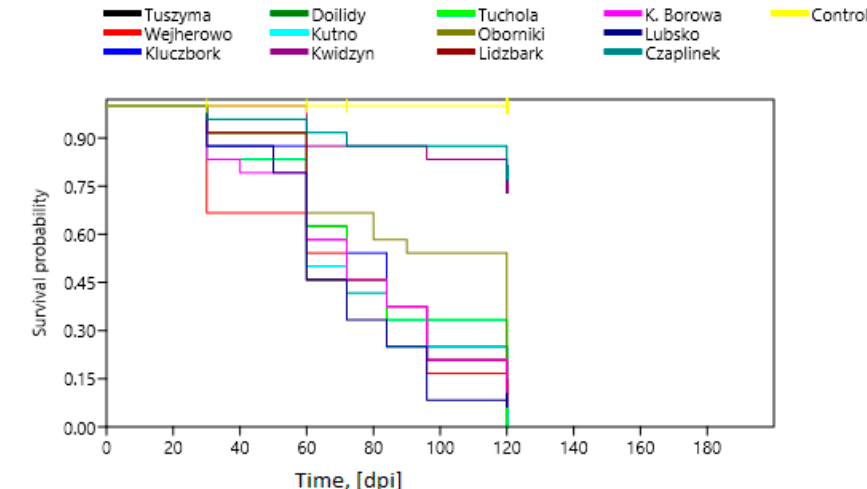
Figure 1. Plot of survival probability determined using the Kaplan-Meier test estimates the survival function for 12 provenances of Pinus sylvestris seedlings infected with Fusarium circinatum.